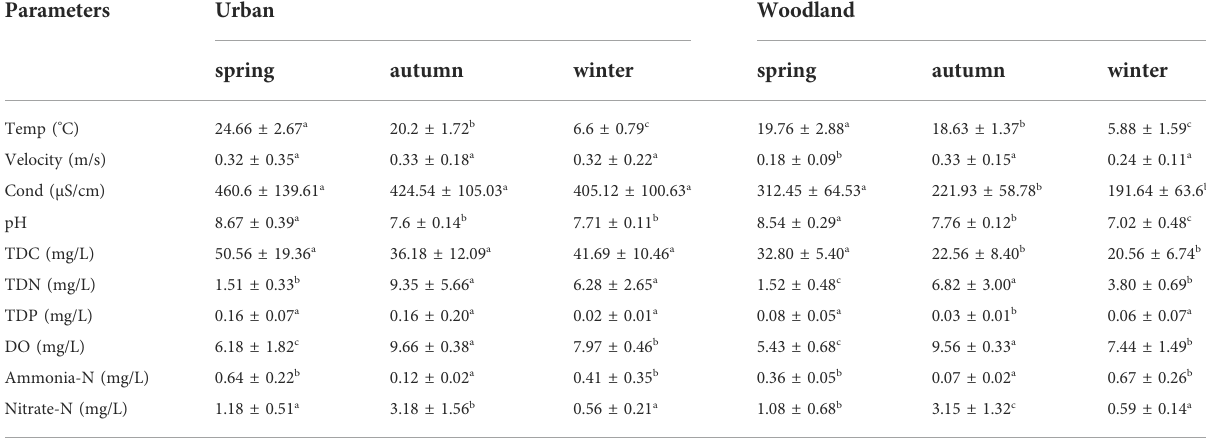
TABLE 1 Physical and chemical parameters at woodland and urban sites in spring, autumn, and winter. Temp and Cond are abbreviations for water temperature and conductivity.